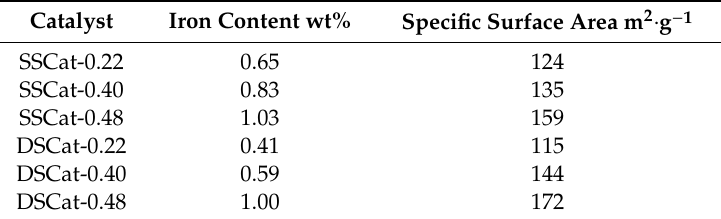
Table 2. Feature of SScat and DSCat catalysts synthesized with R = 0.48, 0.40, and 0.22 at the first stage of CO 2 laser pyrolysis reactor.